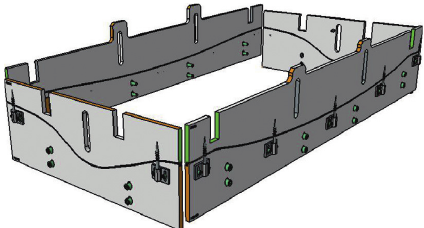
Figure 1: Material frame of trunk trim panel.